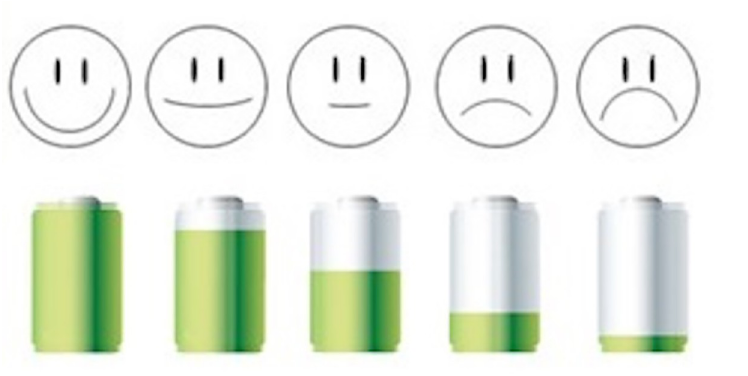
Fig 1. Analogue scales of mood and